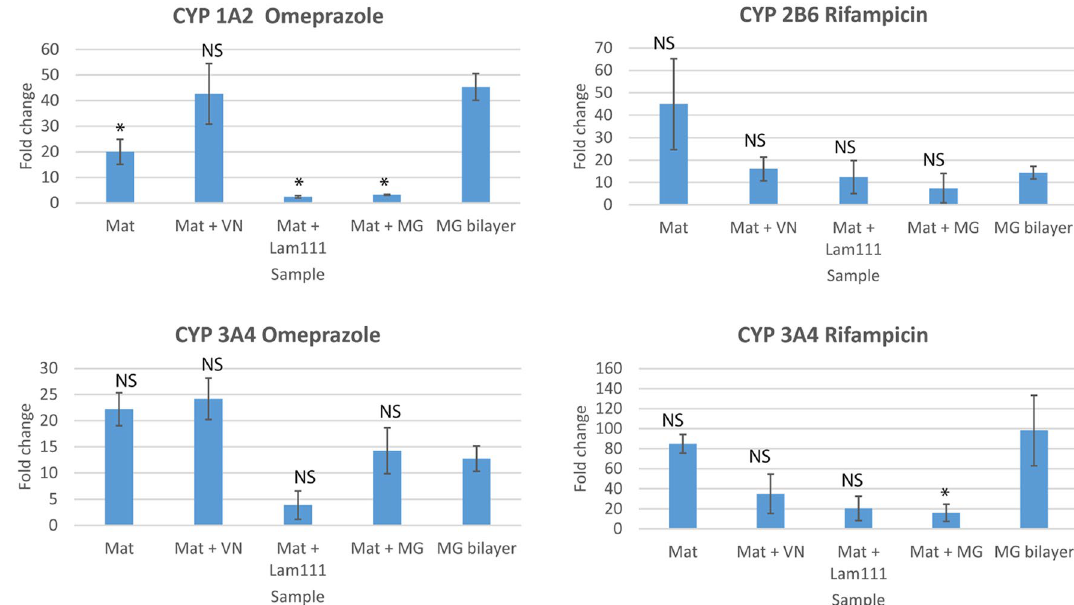
Figure 6. Cytochrome P450 induction in hepatocytes cultured on SBS mats or in MG bilayer. CYP1A2 and CYP3A4 were induced by omeprazole, CYP2B6 and CYP3A4 were induced by rifampicin. The human primary hepatocytes were cultured for 20 days and subsequently treated with indicated compounds for 4 days, n = 5. CYP induction was measured by RT-qPCR, fold changes in mRNA expression were calculated relative to uninduced control cells. * indicates a statistically significant (P < 0.05) difference compared to MG bilayer; NS not significant. Primary hepatocytes were cultured in serum-free hepatocyte defined growth medium.